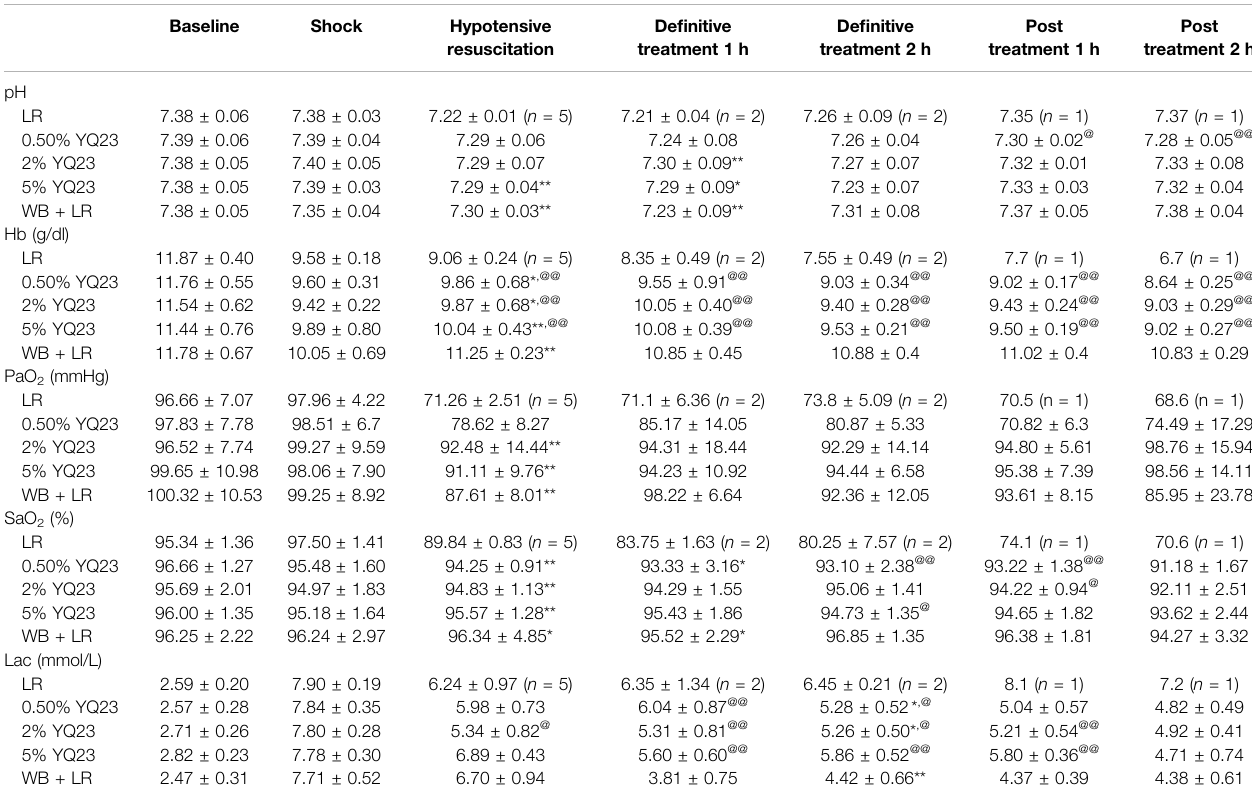
TABLE 1 | YQ23 restored blood gas index in UHS animals. Baseline